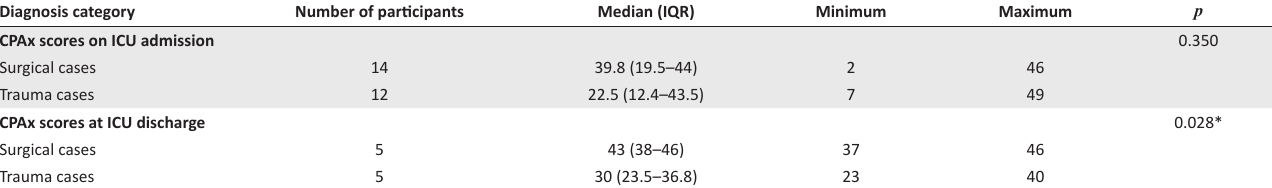
TABLE 2: Differences in Chelsea critical care physical assessment scores between surgical and trauma